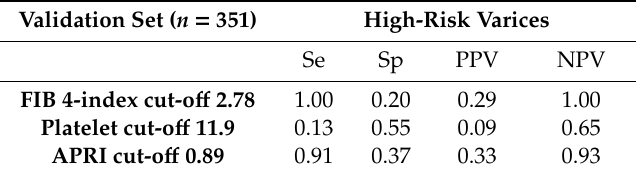
Table 3. Performance of FIB-4, platelet and APRI in the prediction of high-risk varices in the validation cohort ( n = 351).